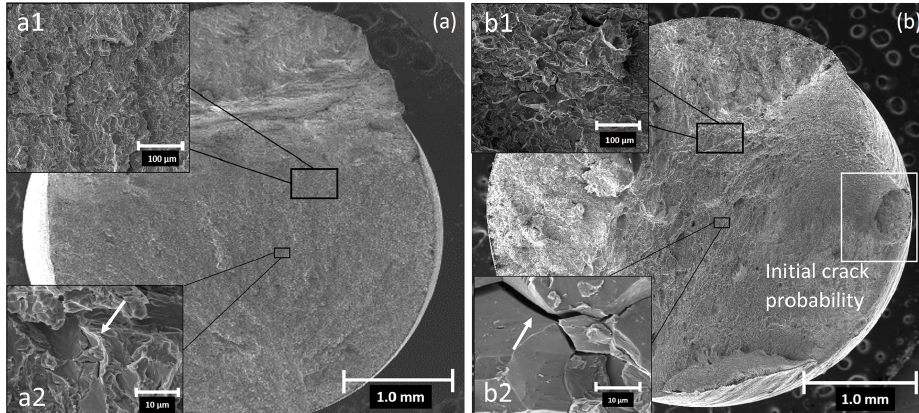
Figure 5. Fractography of ST specimens in HE environment of maraging (a) M300 and (b)